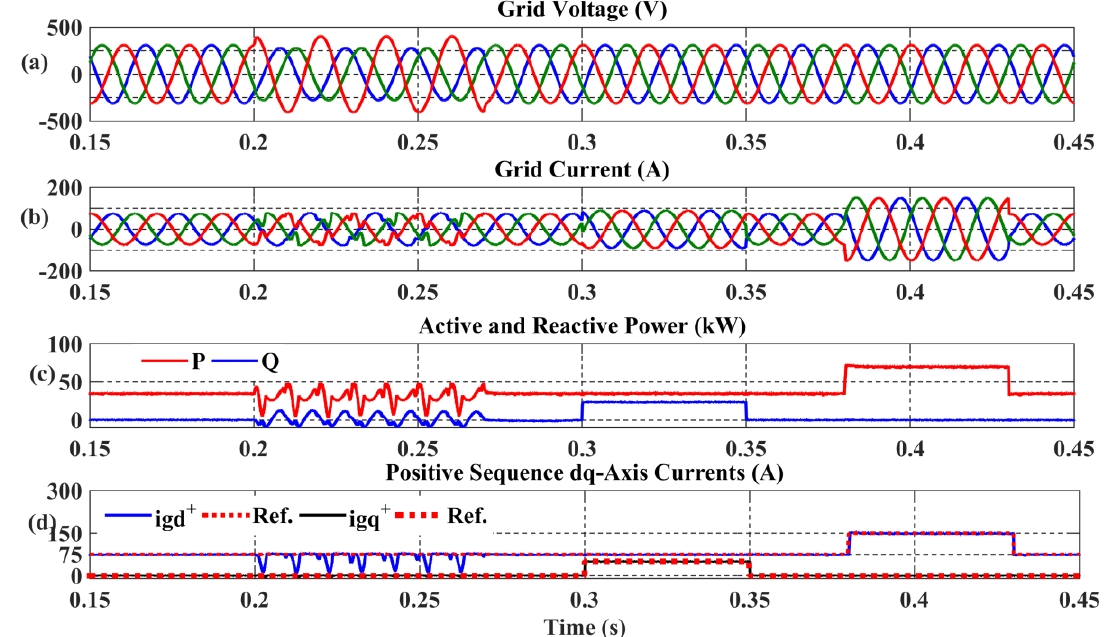
Figure 6. Simulation A results without dual positive- and negative-sequence controllers: ( a ) grid voltage (V) (red: phase-A, blue: phase-B, green: phase-C); ( b ) grid currents (A) (red: phase-A, blue: phase-B, green: phase-C); ( c ) P g (kW) and Q g (kVAr); and ( d ) positive-sequence dq axis currents (A).